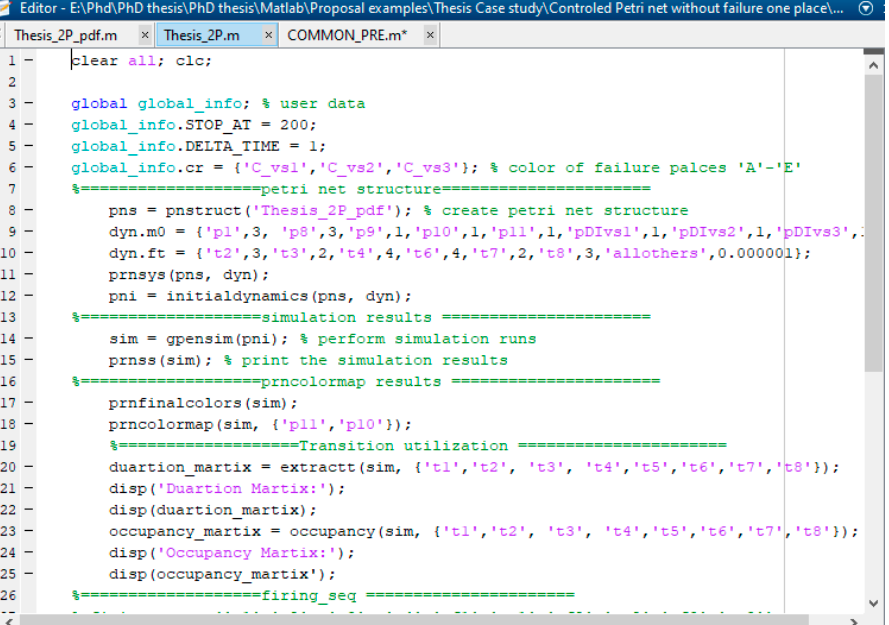
Figure 9. Part of the MSF file of the colored controlled S 3 PR Petri net model from Figure 7.